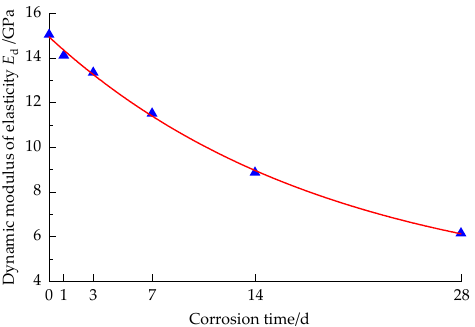
Figure 8. Variation curve of dynamic elastic modulus with the solution corrosion